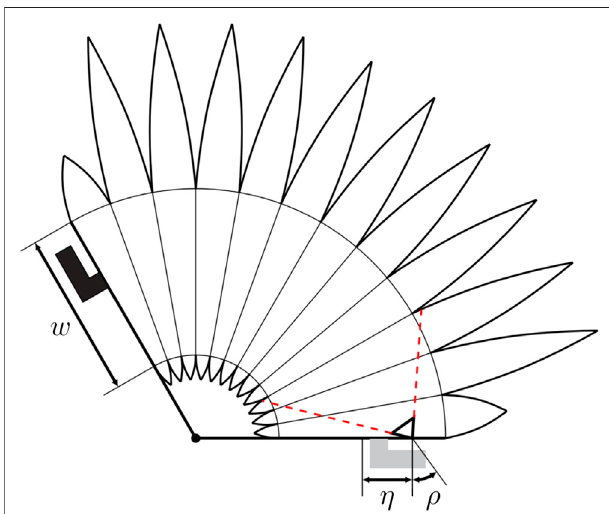
FIGURE 3 | The fi gure shows a simpli fi ed sketch of the cross section of an actuator withthevisibleareaofthecamera indicated inred(dashed).Angle connectors are attached to both the top (shown in black on the left of the fi gure) and bottom of the actuator (shown in gray in the bottom of the fi gure). The bottom connector is used to pressurize the actuator and the top connector to align it with the movable link. The inner opening which connects neighboring cushions has a width denoted by w and plays a crucial role in the resulting visible area of the camera. If the opening is suf fi ciently wide, the majority of the cushions are within the visible area of the camera. The area of the actuator deformation covered by the camera is increased if the camera is placedwithanoffset η withrespecttothecenteroftheinneropeningandtilted by an angle ρ with respect to the normal direction.